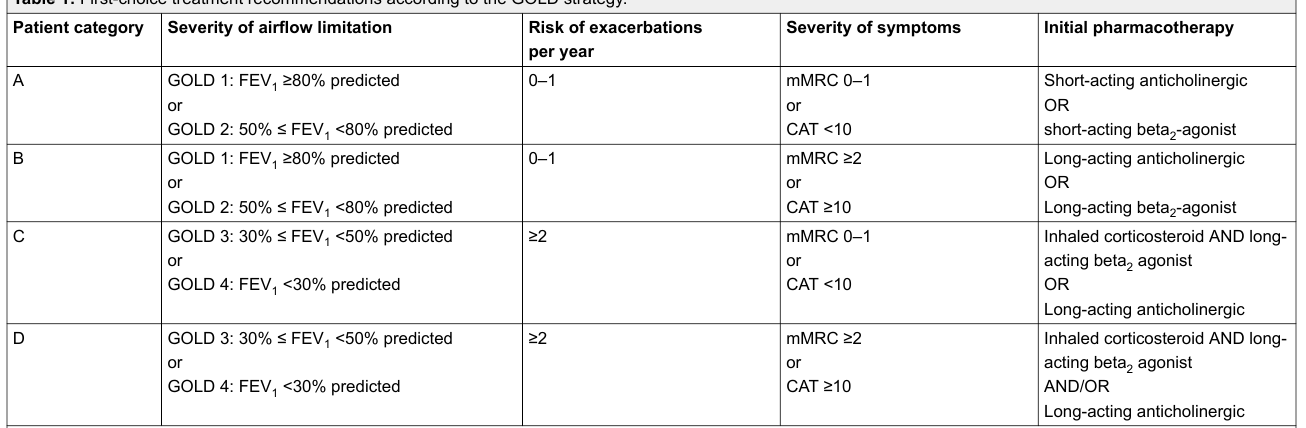
Table 1: First-choice treatment recommendations according to the GOLD strategy. Patient category Severity of airflow